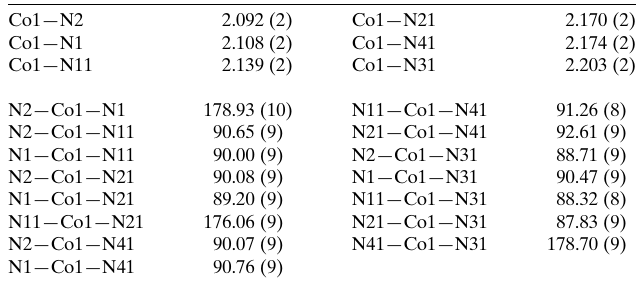
Table 1 Selected geometric parameters (A˚ , (cid:5)